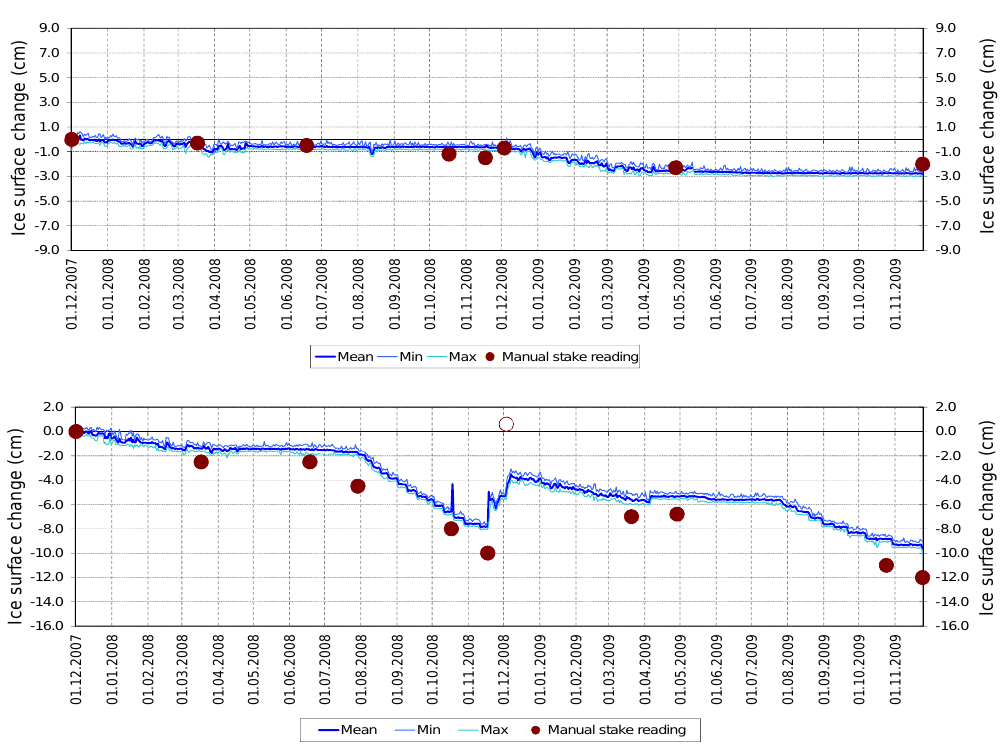
Fig. 5. Time series of accumulated ice surface changes of Eisriesenwelt ice body measured by ultrasonic range sensors at two sites Odinsaal (top panel) and Posselthalle unten (bottom panel) for the period 1 December 2007 and 29 October 2009. For ultrasonic measurements for each day the minimum value (Min), the maximum value (Max) as well as the mean value (Mean) of hourly readings are shown. The net change over the entire period of observations is − 3cm for Odinsaal and − 9cm for Posselthalle unten from the ultrasonic measurements. The white dot marks an implausible manual